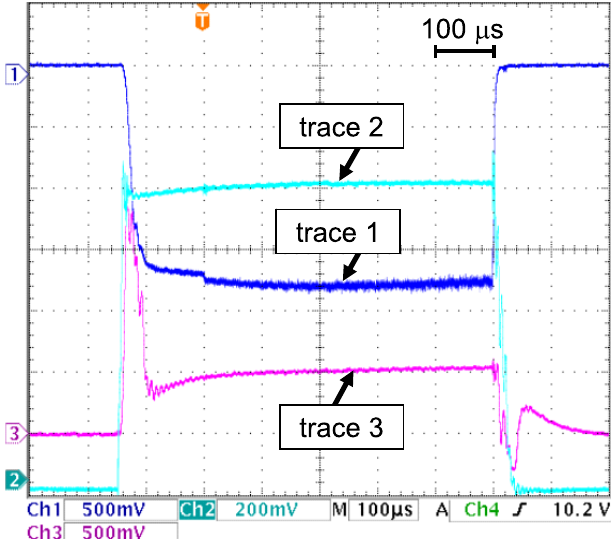
FIG. 15. (Color) Waveforms of beam current (trace 1: 10 mA = div ), arc current (trace 2: 80 A = div ), and arc voltage (trace 3: 150 V = div ).